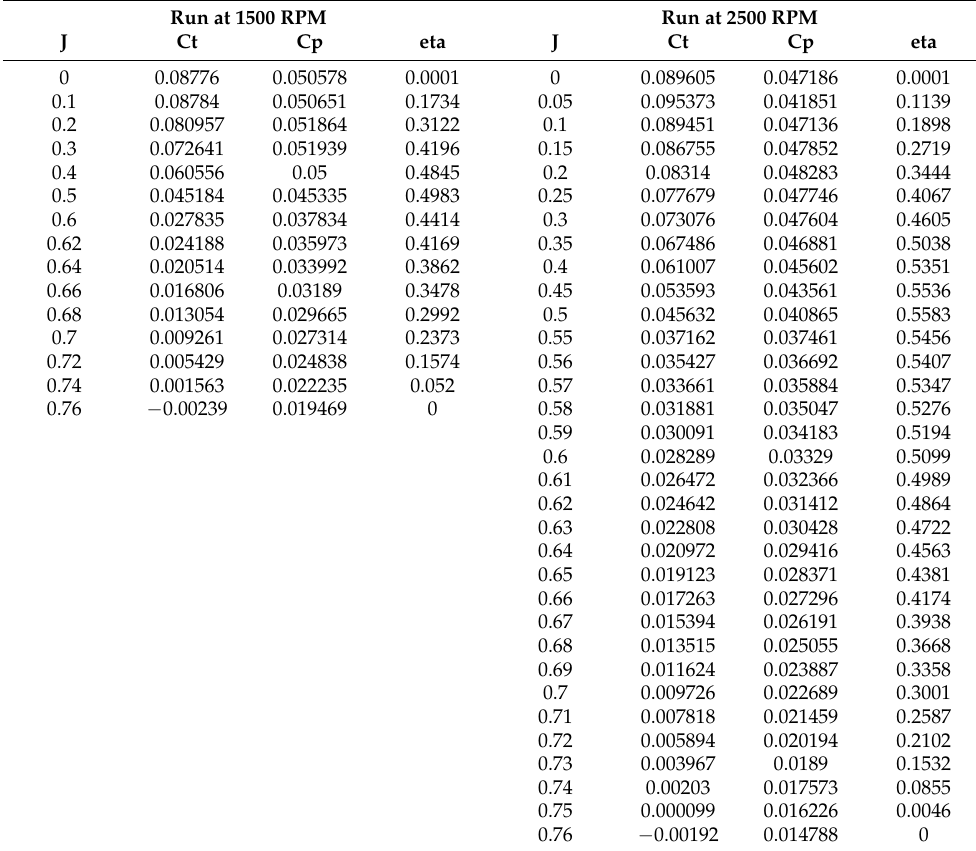
Table A25. BEMT 18 × 12 APC propeller data.